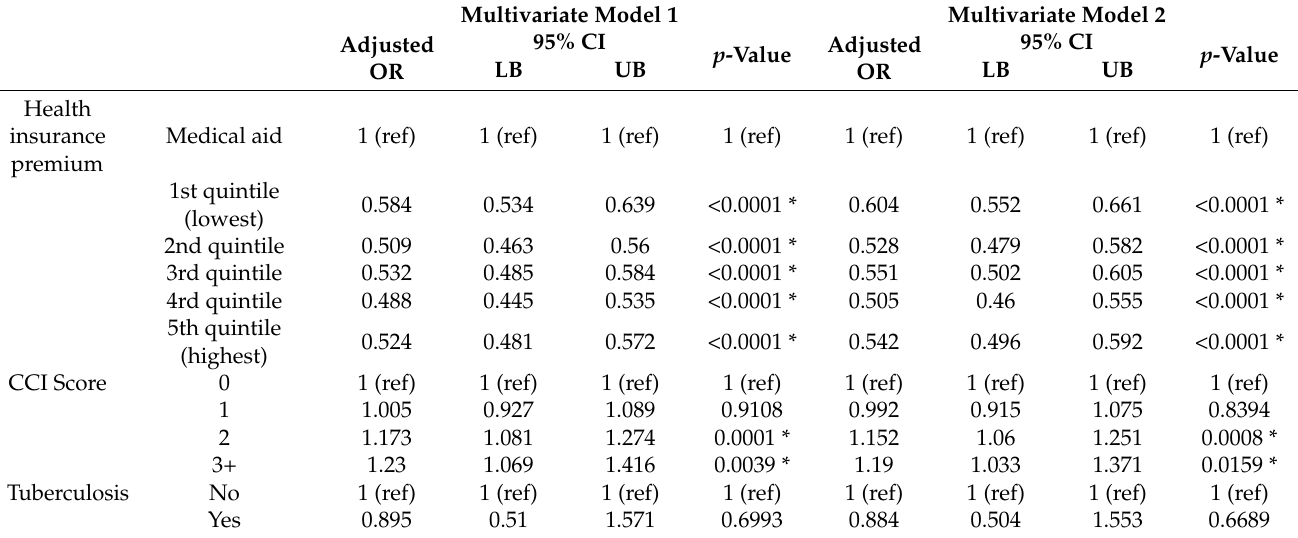
Table 2. Odds ratio for the risk of SARS-CoV-2 infection. Multivariate Model